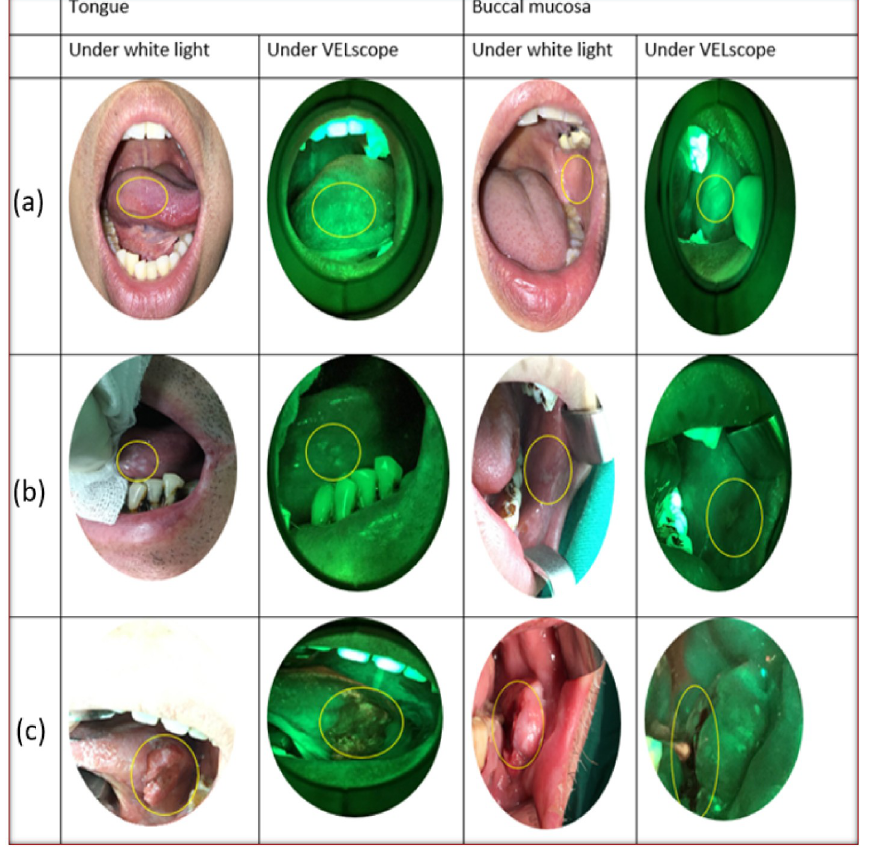
Fig 1. The white light and VELscope autofluorescence images of the tongue and buccal mucosa in selected ROI with (a) Normal, (b) Premalignant and (c) Malignant lesion.